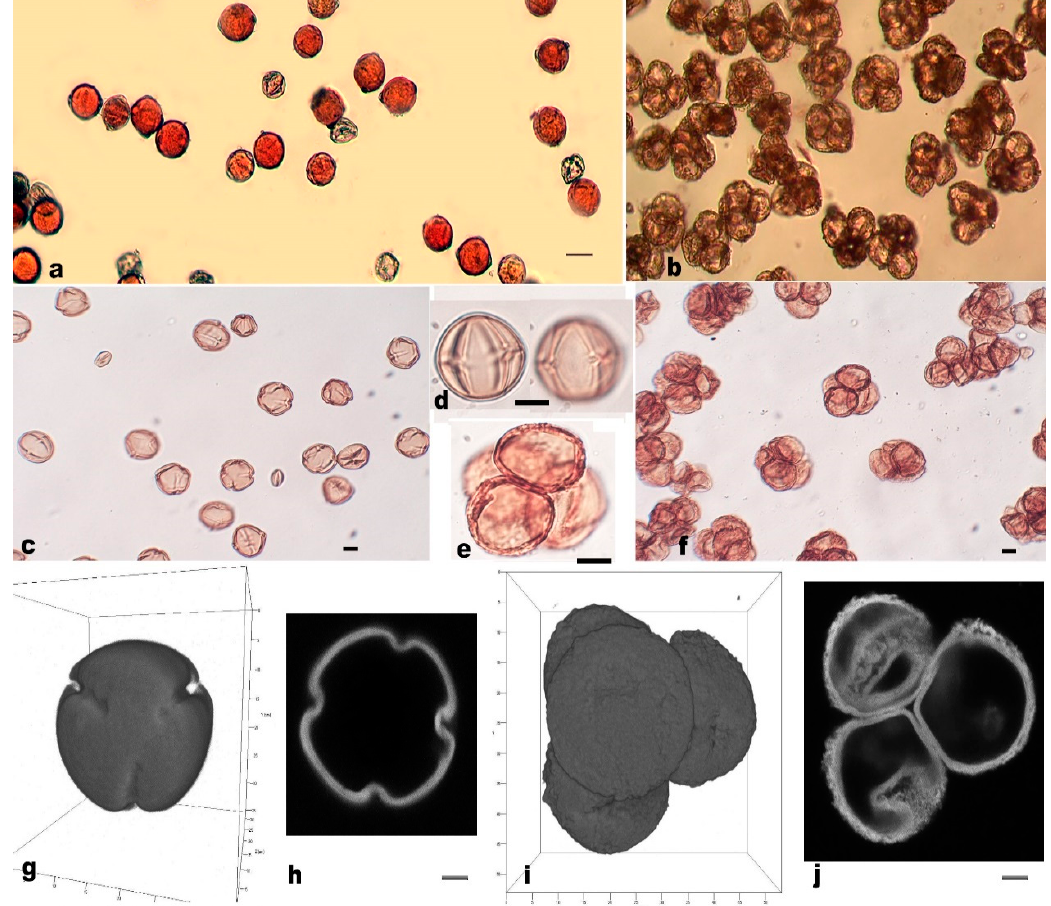
Figure 5. Light microscopy (LM) and confocal laser scanning microscopy (CLSM) images of male-fertile and male-sterile pollen grains. a, b–LM images of pollen, stained with acetocarmine from male-fertile cv. Lomonosovskij ( a ) and male-sterile line 1604/16 ( b ) potato genotypes. c-f–LM images of acetolysed pollen grains from male-fertile cv. Lomonosovskij ( c , d ) and male-sterile cv. Sudarynja ( e , f ). Scale bar–10 µ m. g-j–CLSM images of acetolysed pollen grains from male-fertile cv. Lomonosovskij ( g , h ) and male-sterile line 1604/16 ( i , j ). Reconstructed pollen images ( g , i ) and optical sections through the pollen ( h ) and tetrads ( j ). Scale bar–5 µm.